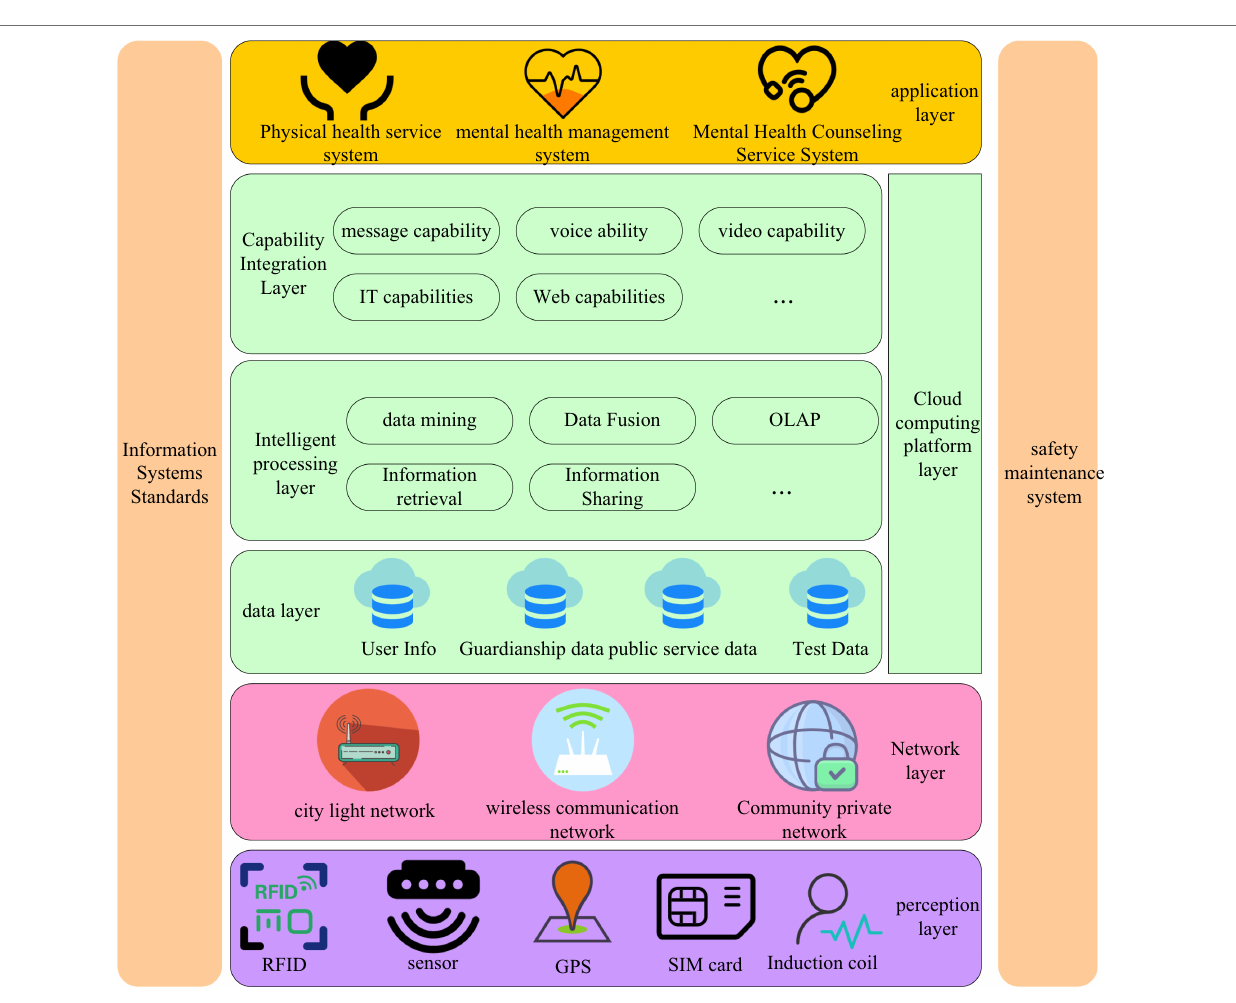
FIGURE 2 | Cloud computing-based mental health service